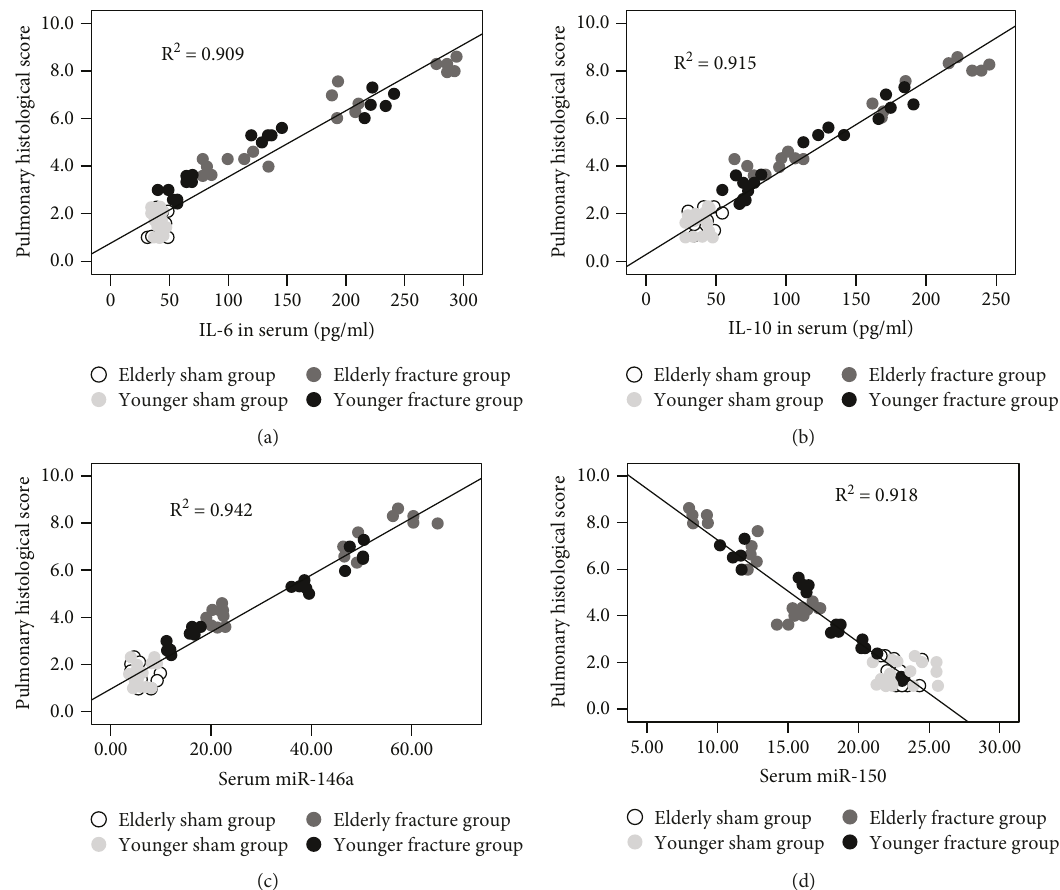
Figure 5: Scatter plots and regression lines showed that the serum IL-6 (a), IL-10 (b), miRNA-146a (c), and miRNA-150 (d) levels exhibited a signi fi cant relationship with the pulmonary histological